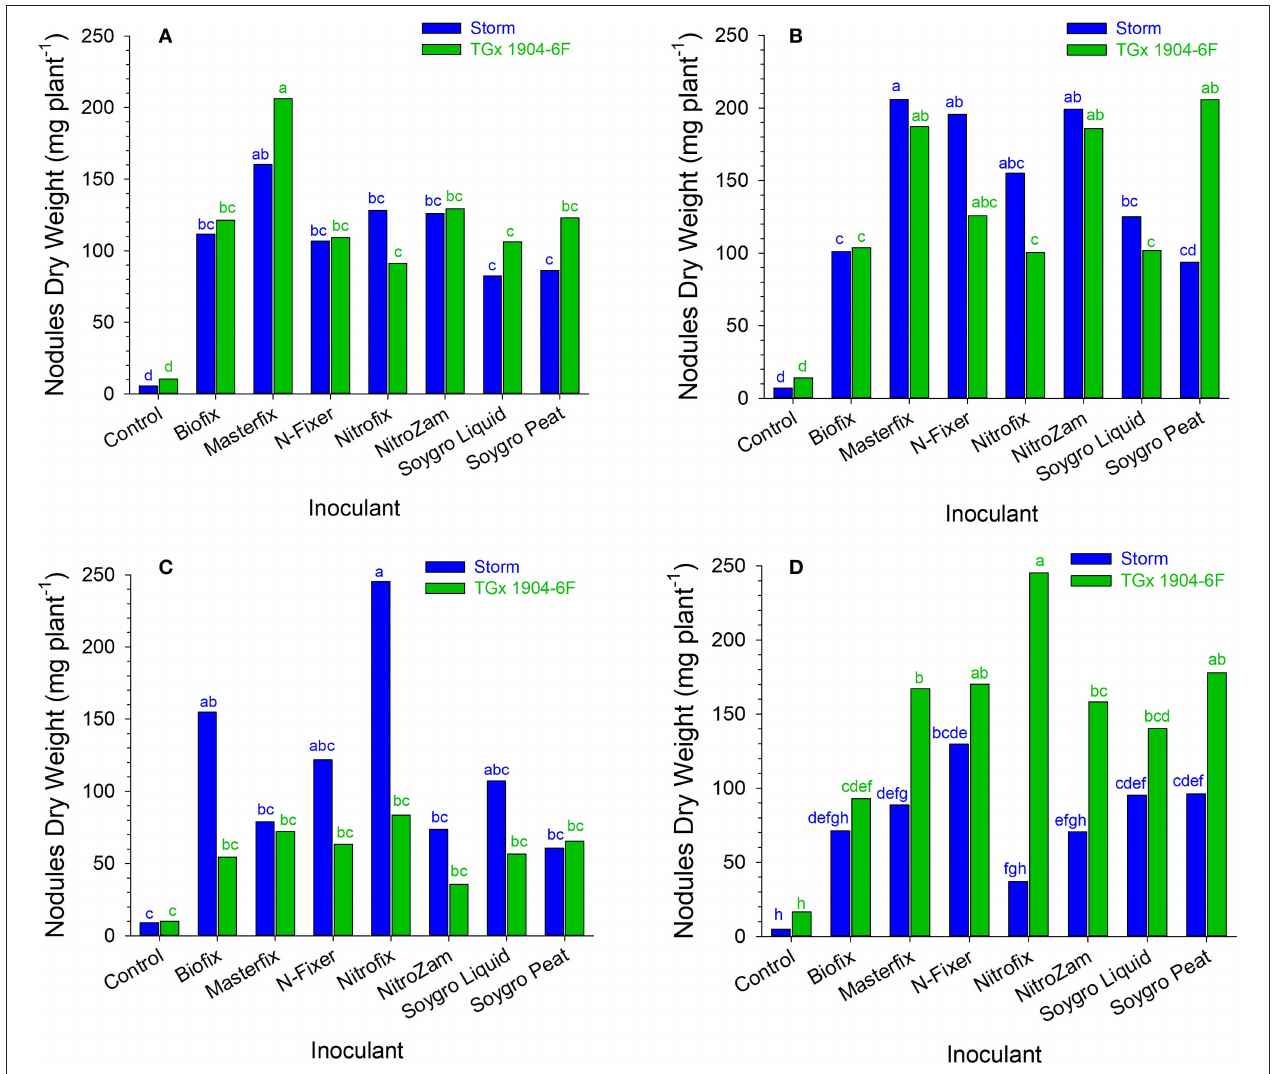
FIGURE 2 | Nodule dry weight (mg plant − 1 ) following inoculation of soybean at (A) Angonia 2016, (B) Ruace 2016, (C) Angonia 2017, and (D) Ruace 2017. Small letters on the bars indicate no significance while different letters show significant differences in